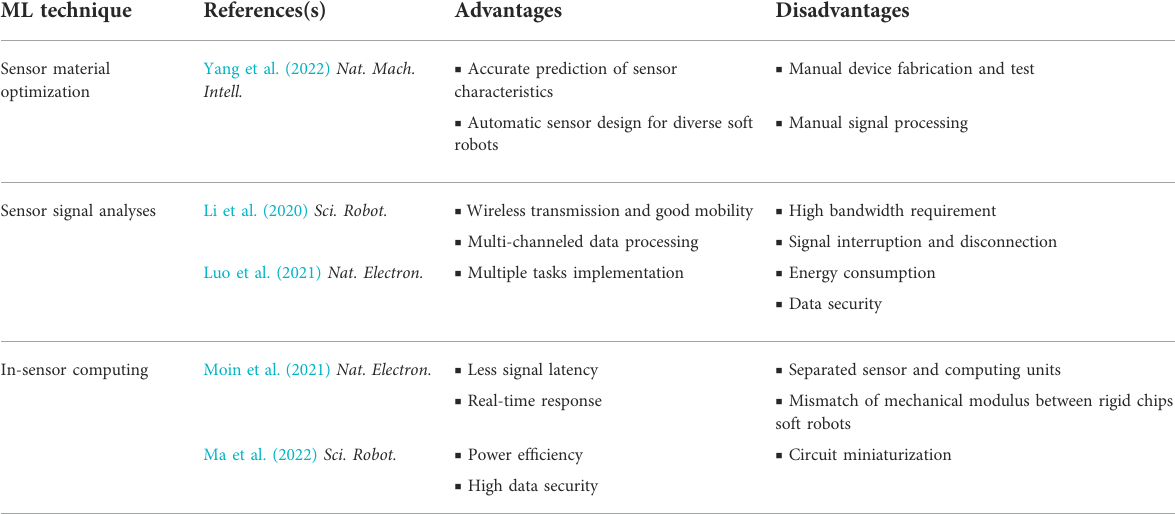
TABLE 1 Summary of ML implementations for strain sensor-integrated soft robots. ML